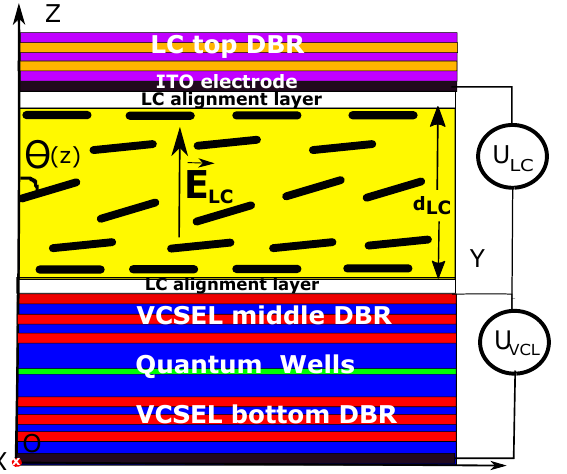
Figure 1. VCSEL with a liquid crystal: an electric field is applied to the liquid crystal layer along the direction of light emission ( E LC (cid:107) Oz ). Planar alignment of the LC molecules close to the LC boundaries is along the Oy axis ensured by the two photo-alignment